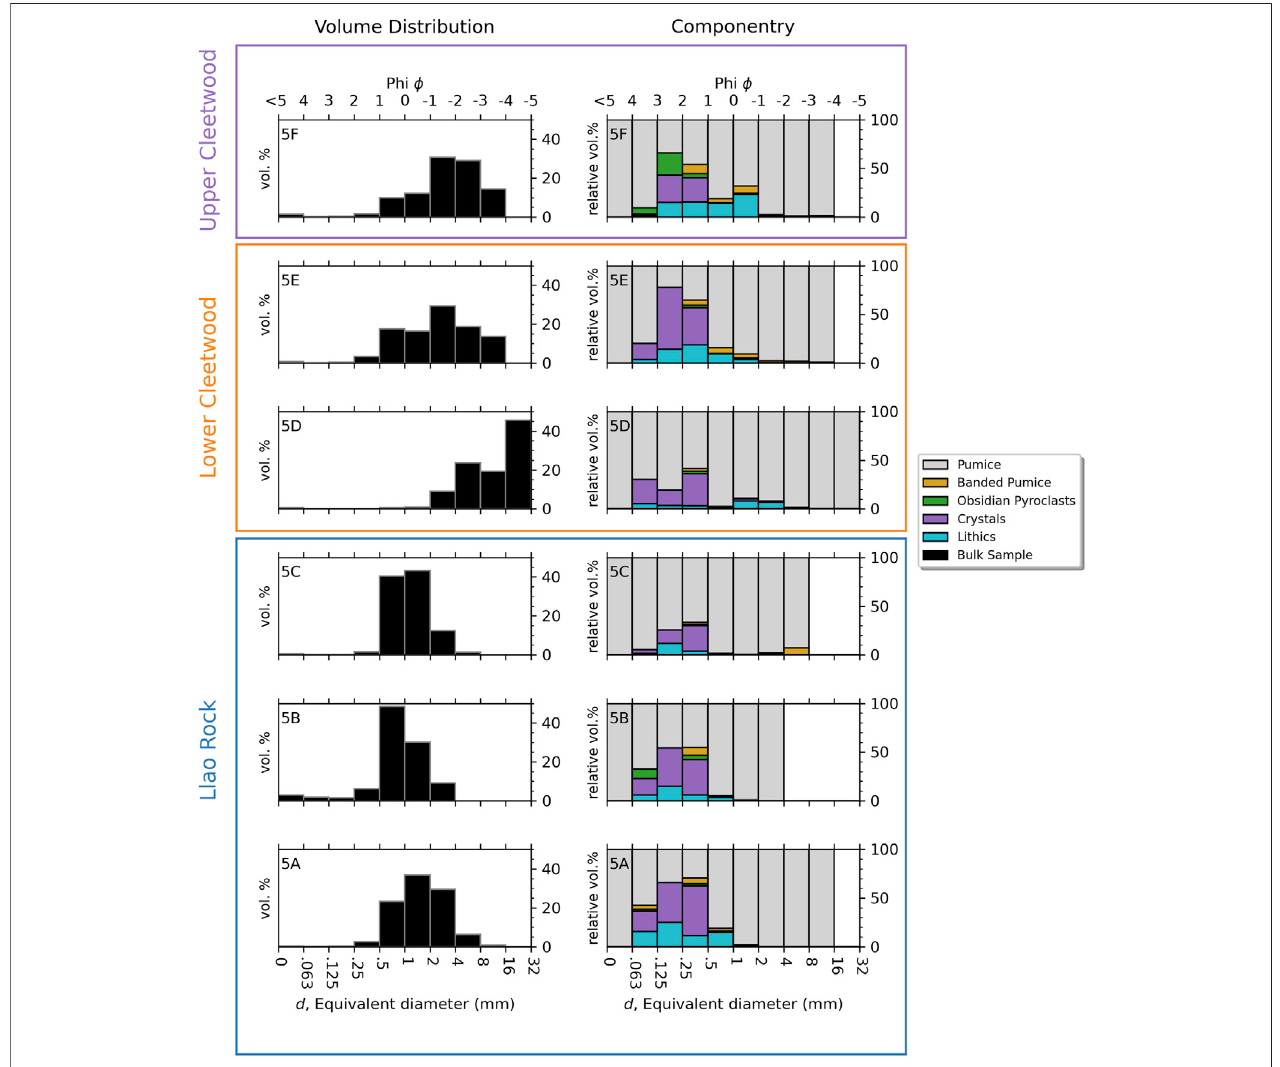
FIGURE 7 | Volume percent of bulk samples (left) and relative volume percent of individual components within each size fraction (right), plotted as a function of equivalentdiameter, d ,forallsubunitsatlocationCltwd5.Subunits5A,5B,and 5CcomposeLlaoRock,5Dand 5Emake uplowerCleetwood,and upper Cleetwoodis de fi ned solely by subunit